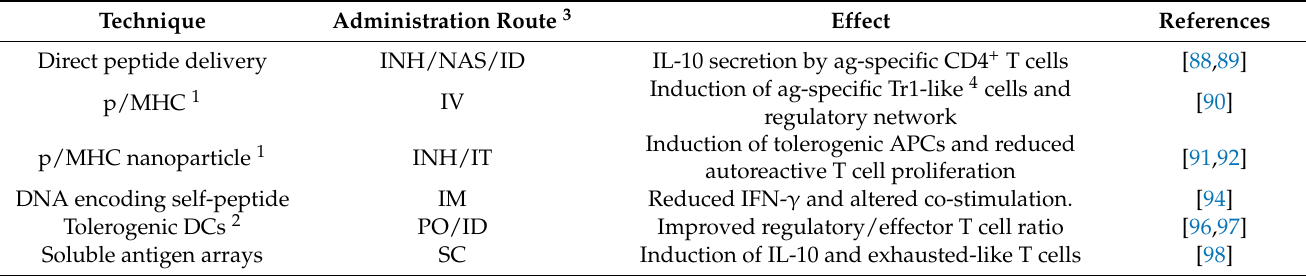
Table 1. Tolerance induction